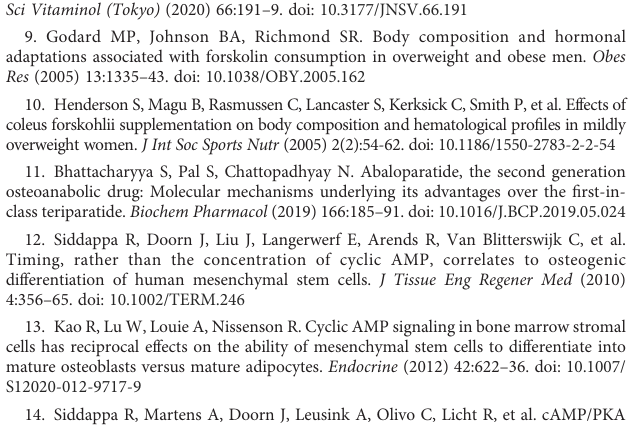
SUPPLEMENTARY FIGURE 1 Qualitative and quantitative analysis of CFE. (A) Chromatogram of the acetonitrile at 220nm. (B) Chromatogram of forskolin standard at 220nm. (C) Chromatogram of the CFE at 220nm. (D) Quanti fi cation of forskolin and isoforskolin in CFE. SUPPLEMENTARY FIGURE 2 CFE decreased fat mass in osteopenic rats. (A) Body mass, (B) normalized fat mass, and (C) lean mass were measured. For parameters shown in (B, C) , Echo- MRI was used. All data are expressed as mean ± SEM (n = 6 rats per group); *p <.05, **p <.01, and ***p<0.001 vs.